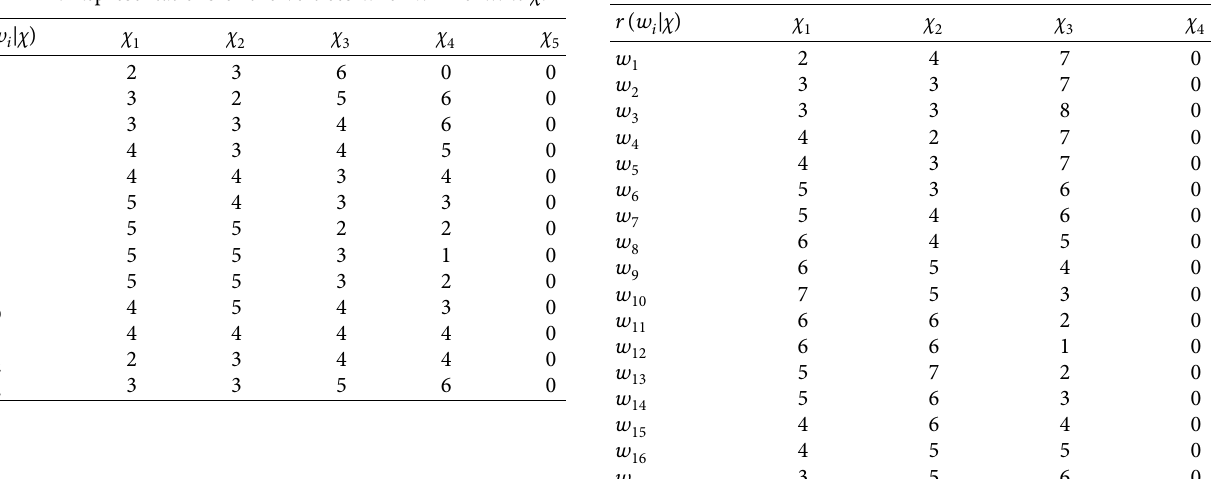
Table 2: Representations of the vertices when n � 13 w.r.t χ